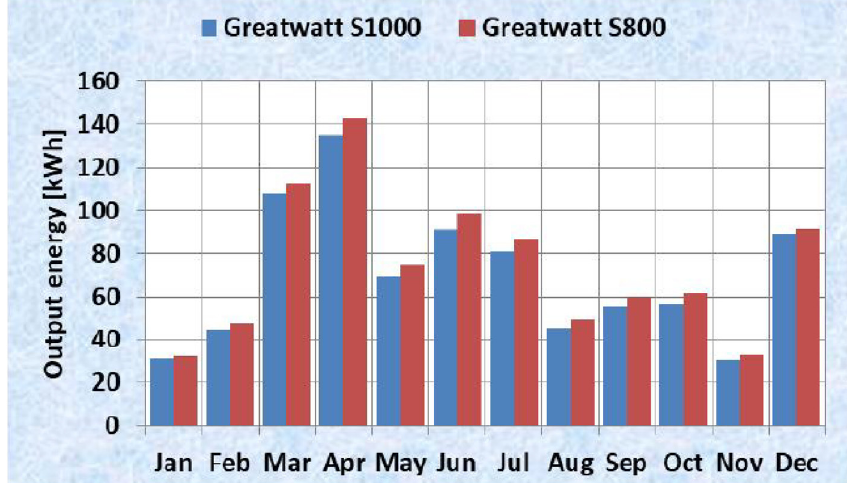
Figure 7. Monthly energy yield comparison, [23].